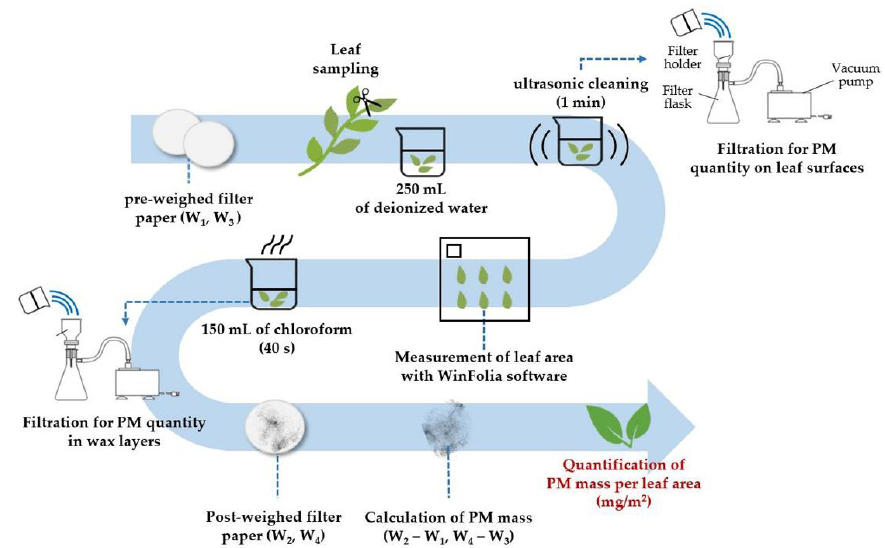
Figure 2. Schematic diagram for quantitative analysis of particulate matter (PM) adsorption using a solid suspension filtering apparatus. W 1 , W 2 , W 3 , and W 4 denote the weight of each quantitative filter paper, the weight of the filter paper dried for 24 h after filtration, the weight of initial each PTFE filter paper, and the weight of the PTFE filter paper dried for 24 h after filtration, respectively.